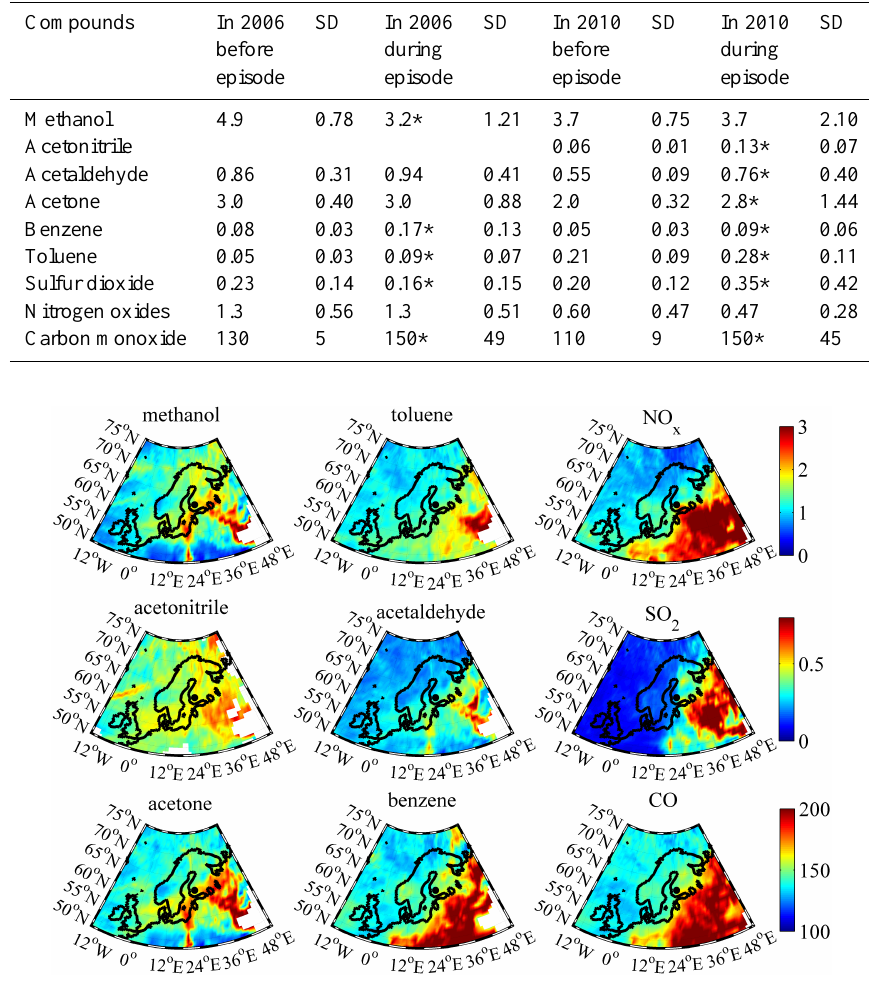
Figure 5. Mean trajectory fields (2006–2011) of selected VOCs and trace gases (ppb v ). VMR scales are presented on the right, with the scale for each compound being further multiplied in the case of each compound by the indicated factor 10, 100 or 1000 if needed. Topmost row: methanol, toluene (multiplied by 10) and NO x . Middle row: acetonitrile (multiplied by 10), acetaldehyde, SO 2 . Bottom row: acetone (multiplied by 100), benzene (multiplied by 1000) and CO. The SMEAR II site is marked by a dot in the